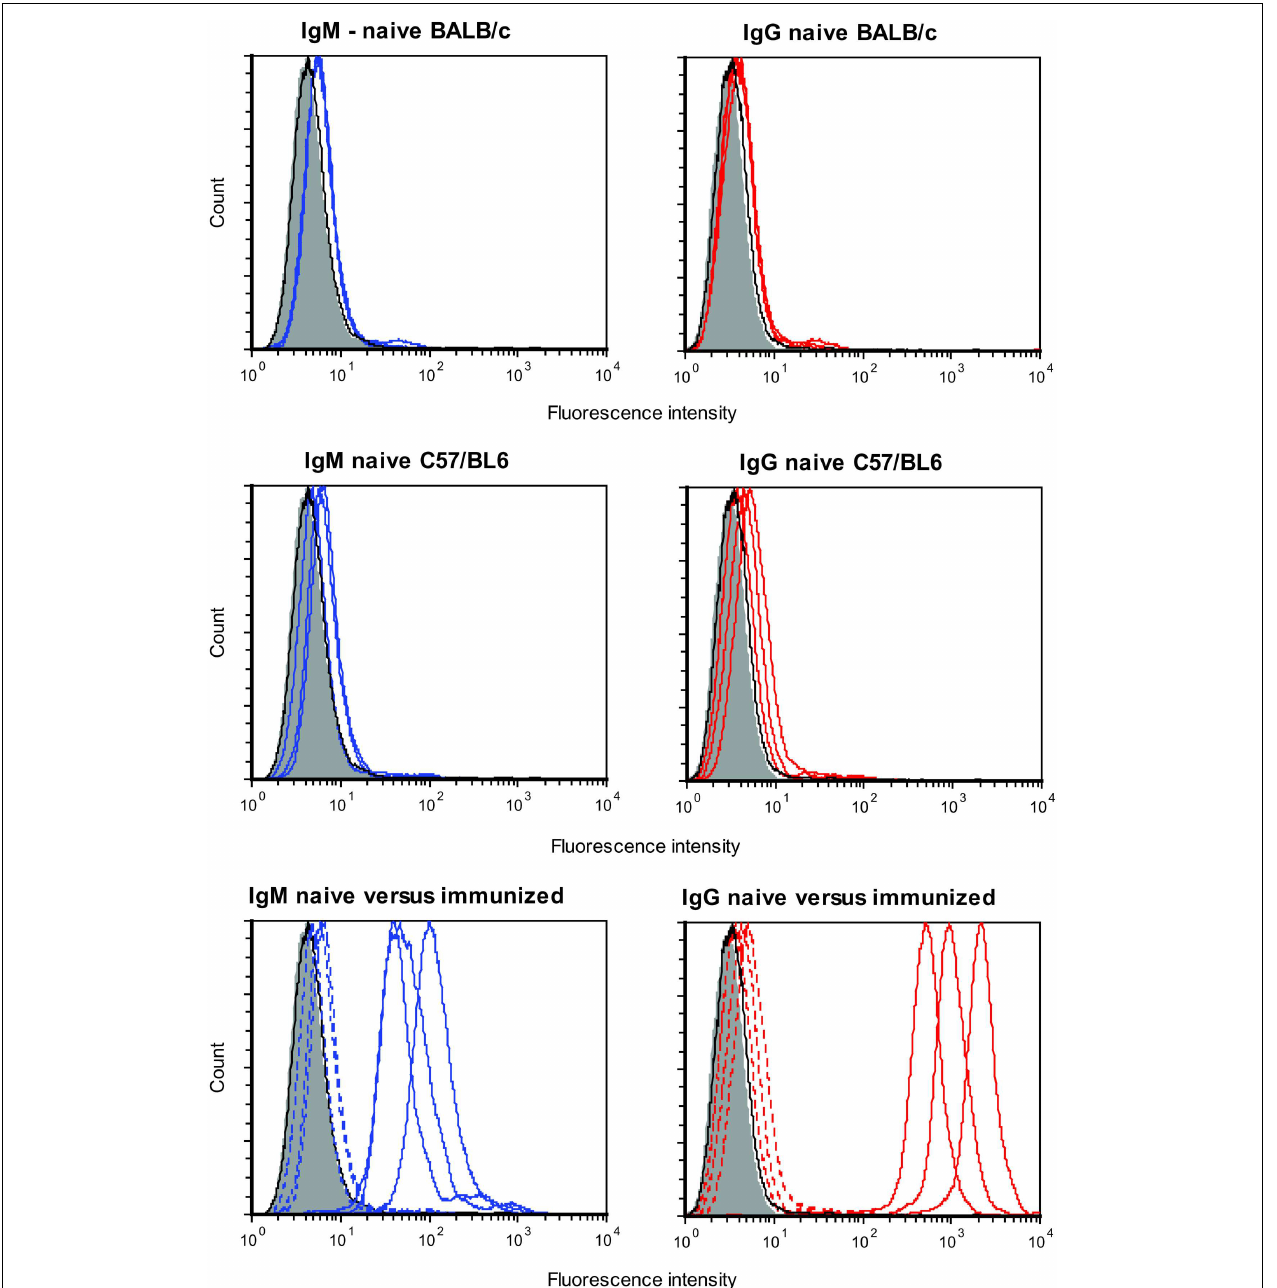
Shaded areas represent no primary antibody, solid black lines represents isotype (IgM or IgG) control, blue lines represent IgM anti-DFTD antibodies, red lines represent IgG anti-DFTD; lower panel, dotted lines represent serum from naïve mice, solid lines represent serum from mice immunized intraperitoneally with